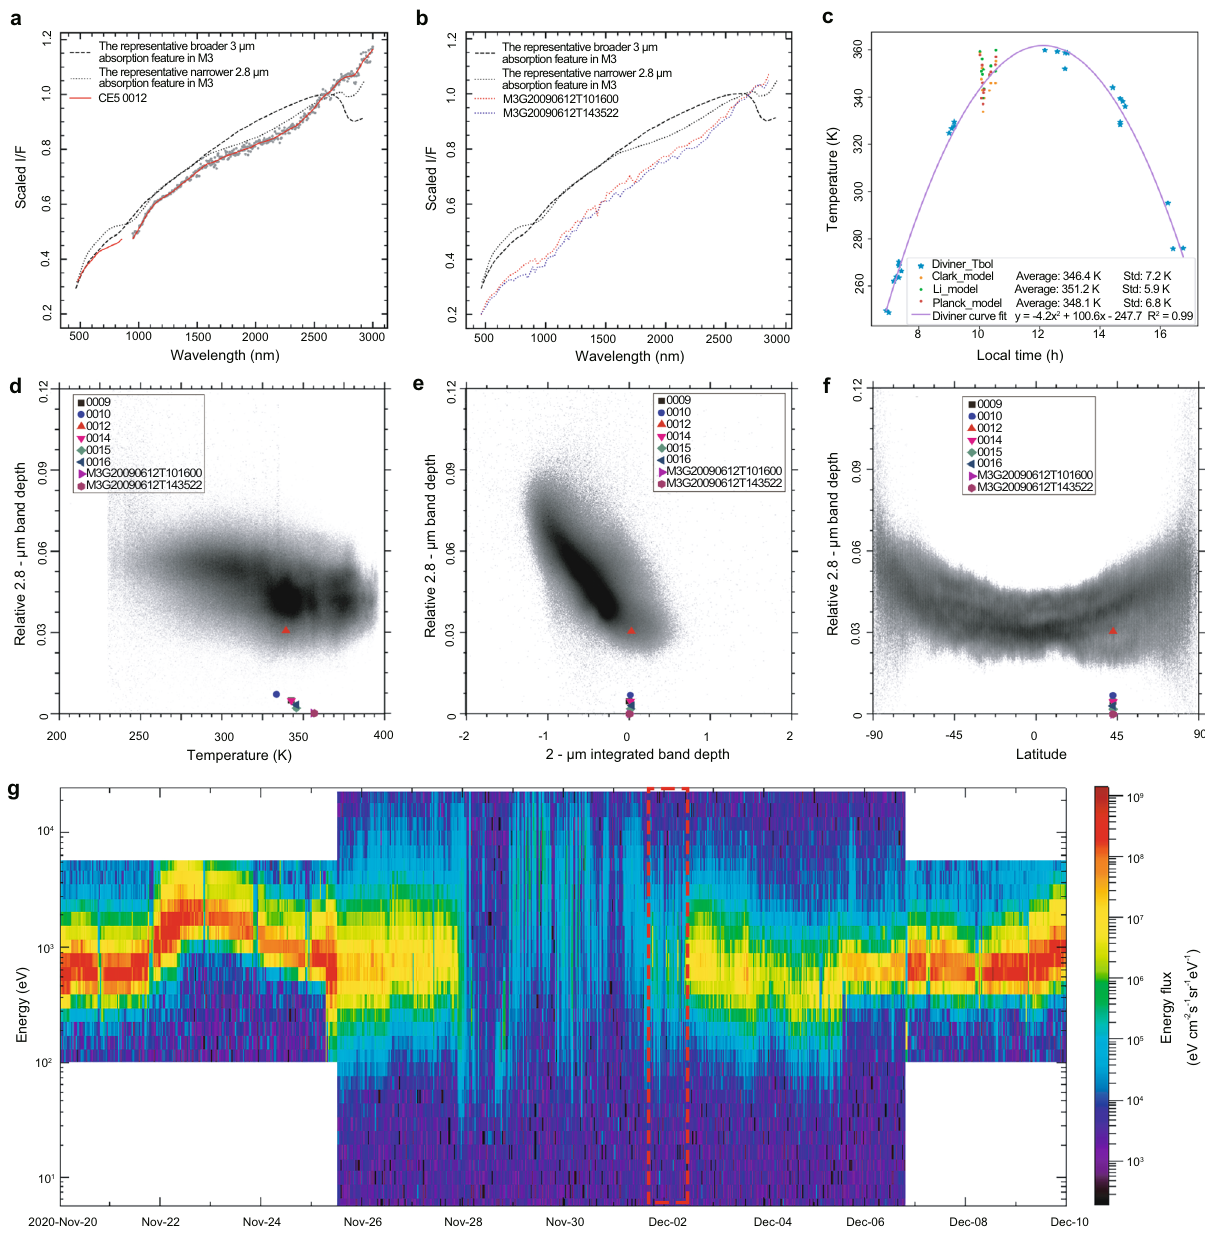
Fig. 4 The OH absorption features comparison between the lunar mineralogical spectrometer (LMS) in situ spectra and remote sensing spectra of the Moon Mineralogy Mapper (M 3 ). a The examples of LMS 0012 (red solid line), the representative broader 3 μ m (dashed line), and 2.8 μ m (dotted line) absorption features of M 3 . b The examples of two M 3 spectra of Chang ’ E-5 landing site obtained at different times, the representative broader 3 μ m (dashed line) and 2.8 μ m (dotted line) absorption features of M 3 . c The lunar surface temperatures derived from three thermal correction models (Clark model, Li model, and Groussin model, see “ Methods ” ) at the time of LMS in situ observations. The average temperatures derived from three models are 347.9, 351.2, and 348.1 K. The purple curve shows the variation of the lunar surface temperature with local time fi tted from the Diviner data of the Chang ’ e- 5 landing site at different lunar local times. d – f are projections of LMS ~2.85 μ m band depth data to the M 3 global ~2.81 μ m band depth data varied with temperatures, 2 μ m integrated band depths and latitudes (data of shaded areas, which are from Fig. 12b, Fig. 10c, and Fig. 8b of ref. 26 ). g ARTEMIS P1 ion energy fl ux spectrogram from 20 November 2020 to 10 December 2020. The area derived from the red dashed lines in the fi gure indicates the low energy fl uxes of the received solar wind particles during LMS in situ observation period (2020.12.01 – 2021.12.02), when the Moon is under the protection of the Earth ’ s